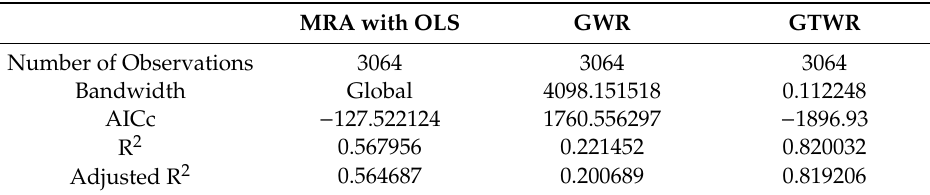
Table 8. Overall performance of all